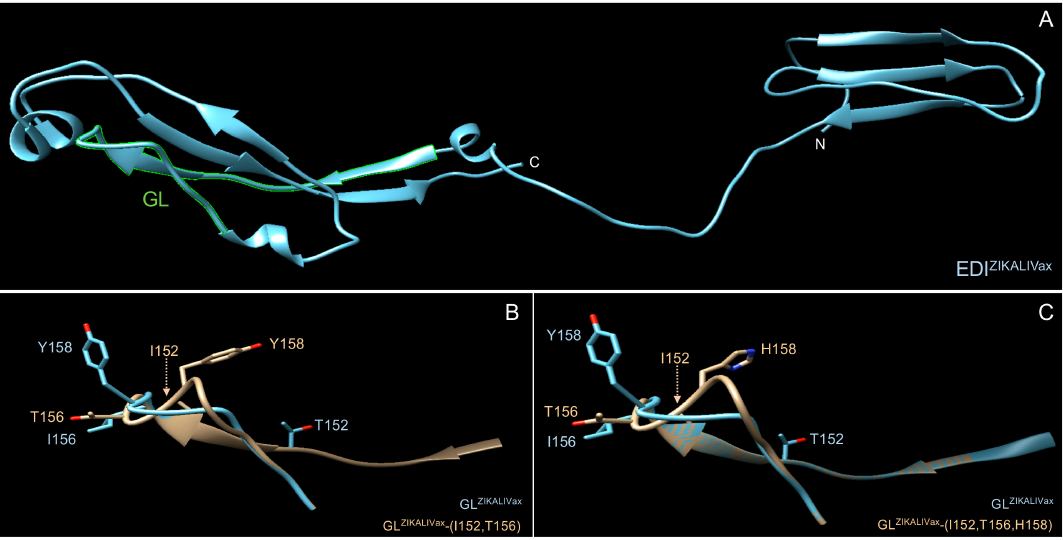
Figure 7. Structural features of rEDI ZIKALIVax . Tridimensional structure prediction of rEDI ZIKALIVax and its mutants was performed by comparative modeling on PHYRE 2 protein recognition server (http: // www.sbg.bio.ic.ac.uk / ~phyre2 / html / page.cgi?id = index). The predicted structures were analyzed with Chimera, a program for interactive visualization of tridimensional molecules. In ( A ), predicted structure of ZIKALIVax rEDI with GL region in green. The two C-terminal tags of rEDI are not presented. In ( B , C ), the ZIKALIVax GL region structure (GL ZIKALIVax ) was compared to GL mutants bearing the two mutations E-T152I, and E-I156T ( B ) or the three mutations E-T152I, E-I156T, and E-Y158H ( C ). The hatched arrow indicates the position of residue I152 in the 3D structure of GL